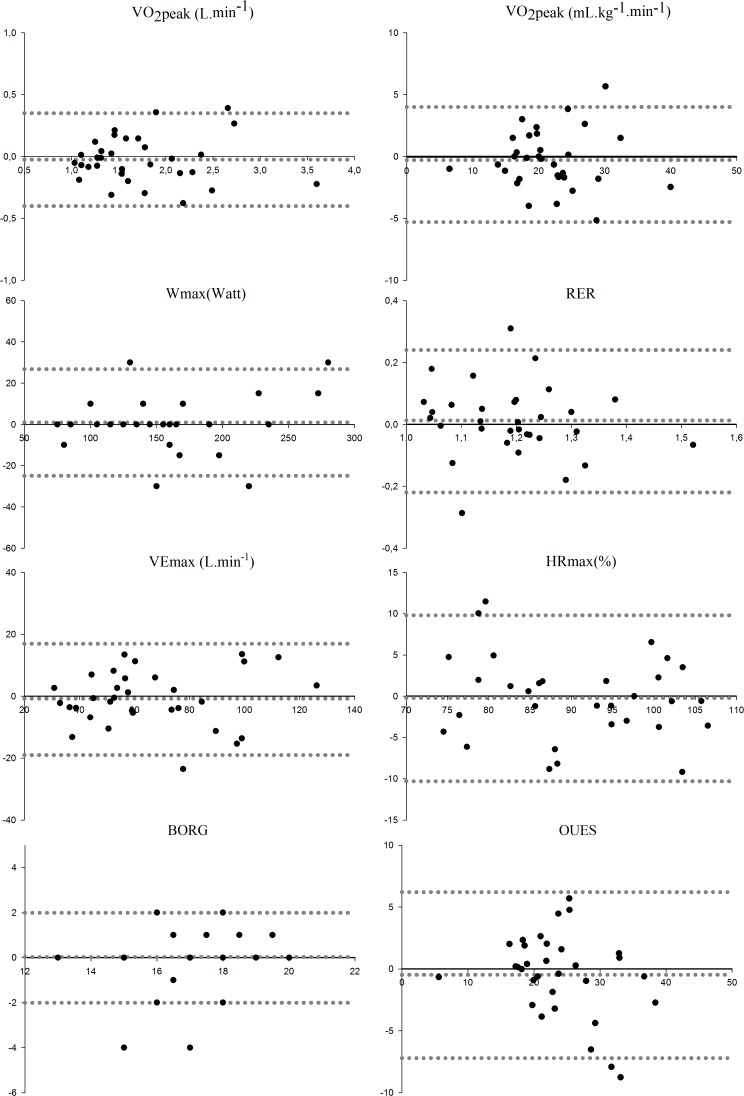
Bland-Altman plots of CPET outcomes in PwMS.BORG, rating of perceived exertion following voluntary exhaustion; HRmax, maximal heart rate expressed as percentage of the age-predicted maximal heart rate (%); OUES, oxygen uptake efficiency slope; RER, respiratory exchange ratio; VE, peak ventilation (L∙min−1); VO2peak, peak oxygen uptake (L∙min−1and mL∙kg−1∙min−1); Wmax, maximal power output (Watt).